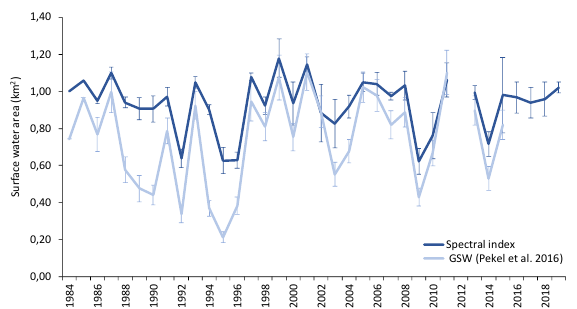
Figure 6. Time series of water surface changes for SNASPE wetlands in the north and central part of